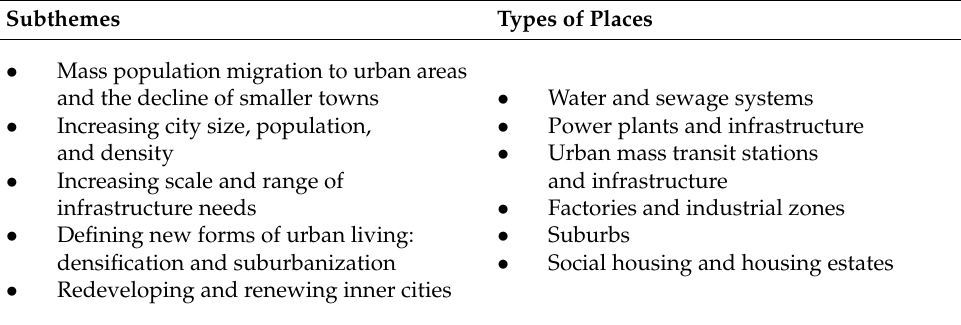
Table 1. Rapid Urbanization and the Growth of Large Cities.